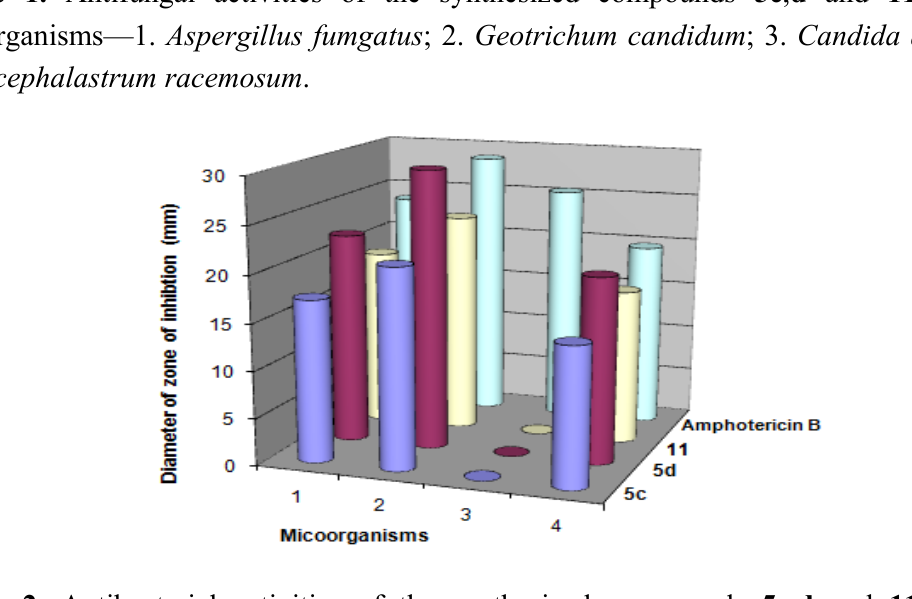
Figure 2. Antibacterial activities of the synthesized compounds 5c , d and 11 against micoorganisms—1. Staphylococcus aureus ; 2. Bacillis subtilis ; 3. Pseudomonas aeruginosa ; 4. Escherichia coli